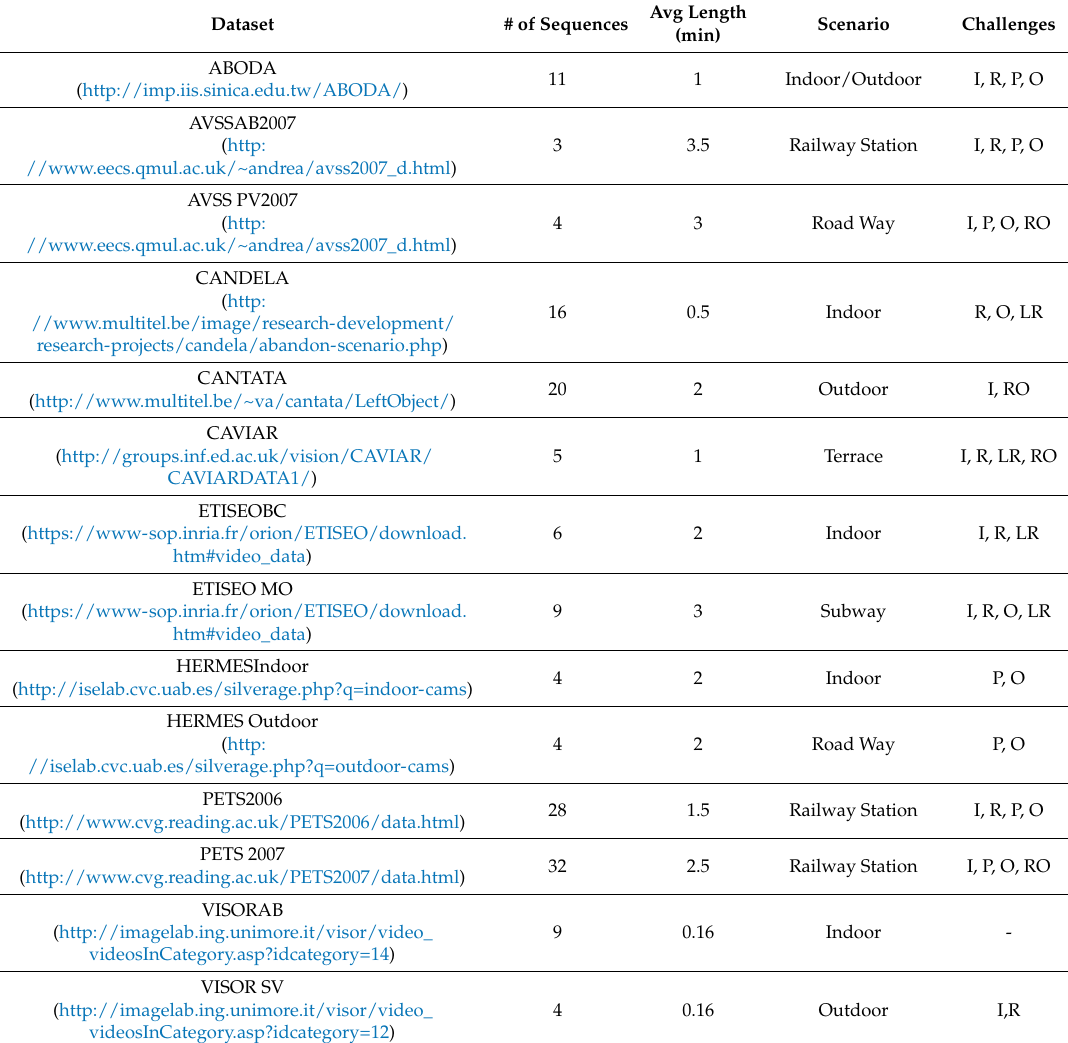
Table 4. Abandoned Object Detection (AOD) datasets available. Key: I = Illumination changes/shadows; R = Remoteness/small objects; P = stationary People; O = Occlusions; LR = Low Resolution; RO = Removed